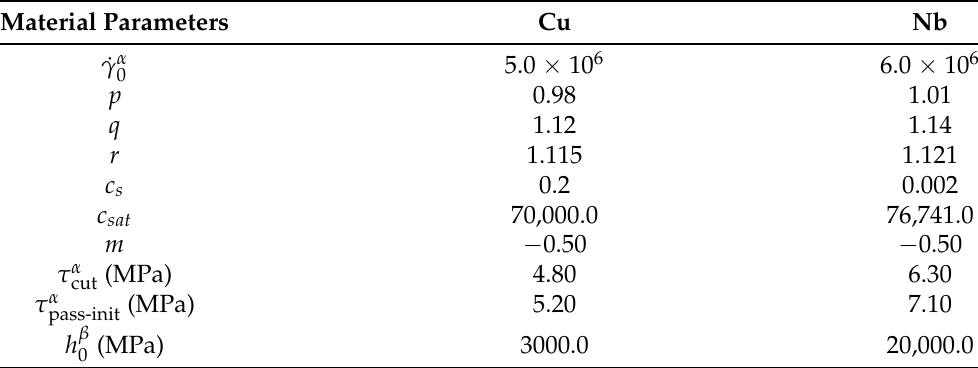
Table 3. Material parameters of copper and niobium acquired from the deep-learning SLC and experimental